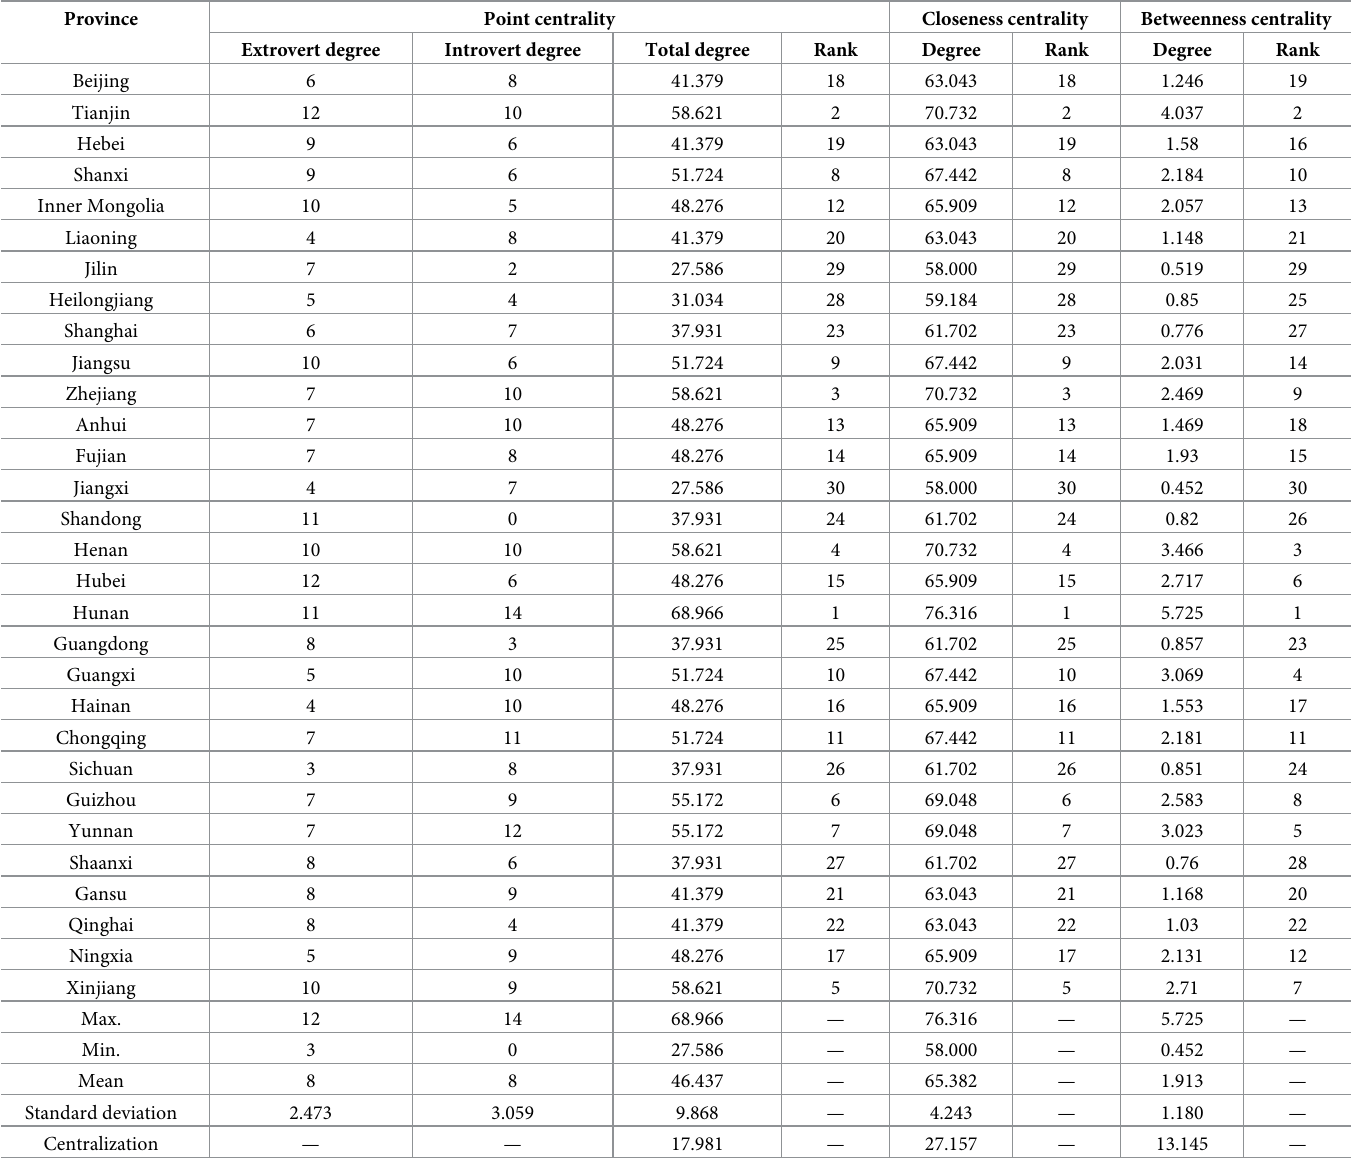
Table 3. Ego network characteristics of China’s green development.